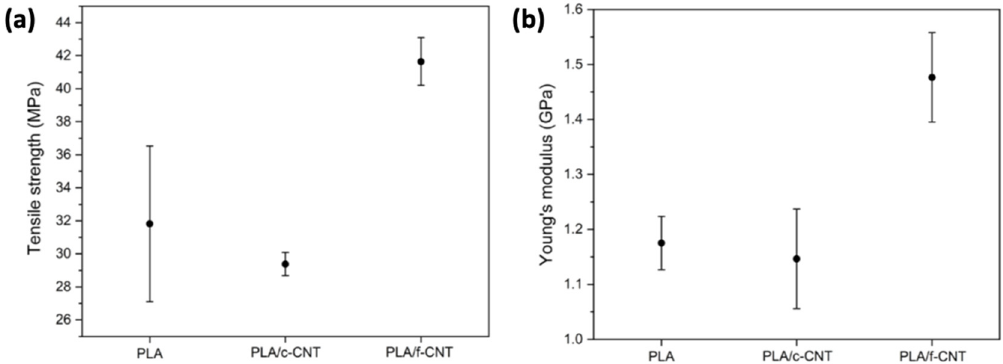
Figure 19. Effects of the c-CNT and f-CNT addition on the ( a ) tensile strength, and ( b ) Young’s modulus [238].